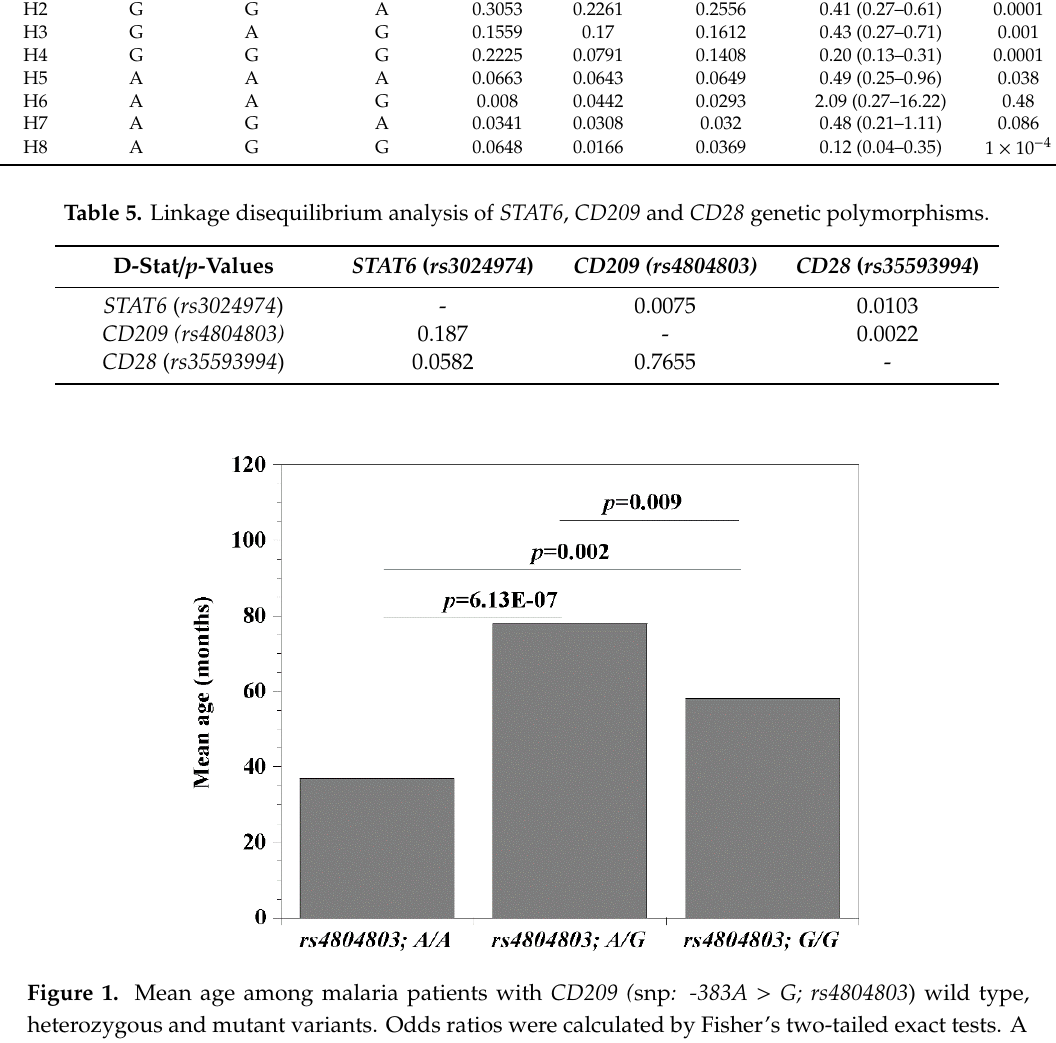
Figure 2. Mean parasitemia among malaria patients with CD209 (snp: -383A > G; rs4804803 ) wild type, heterozygous and mutant variants. Odds ratios were calculated by Fisher’s two-tailed exact tests. A p -value < 0.05 was considered significant. 4. Discussion Malaria is a life-threatening disease, causing global morbidity and mortality among endemic populations and non-immune individuals travelling to such locations, with the most deaths among children under five years of age [3,4,46]. Reports have shown that infection among children could lead to severe clinical episodes, therefore a better understanding of immunoregulation and/or the development of immunity post-infection is imperative. This is especially imperative in sub-Saharan Africa, where Plasmodium falciparum , the most virulent of the species, is endemic. Protective immunity can be acquired naturally after consecutive malaria infections when dendritic cells, serving as antigen-presenting cells, prime and activate the T cells necessary for downstream adaptive response, for which CD209 and CD28 molecules are significant participants [47–49]. Likewise, the STAT6 gene is known to regulate the expression of regulatory T cells [50], while potentially modulating the immune response to malaria [41,42]. Therefore, elucidating the mechanism mediating susceptibility to or resistance against malaria would be significant in combatting disease pathogenesis. Studies on